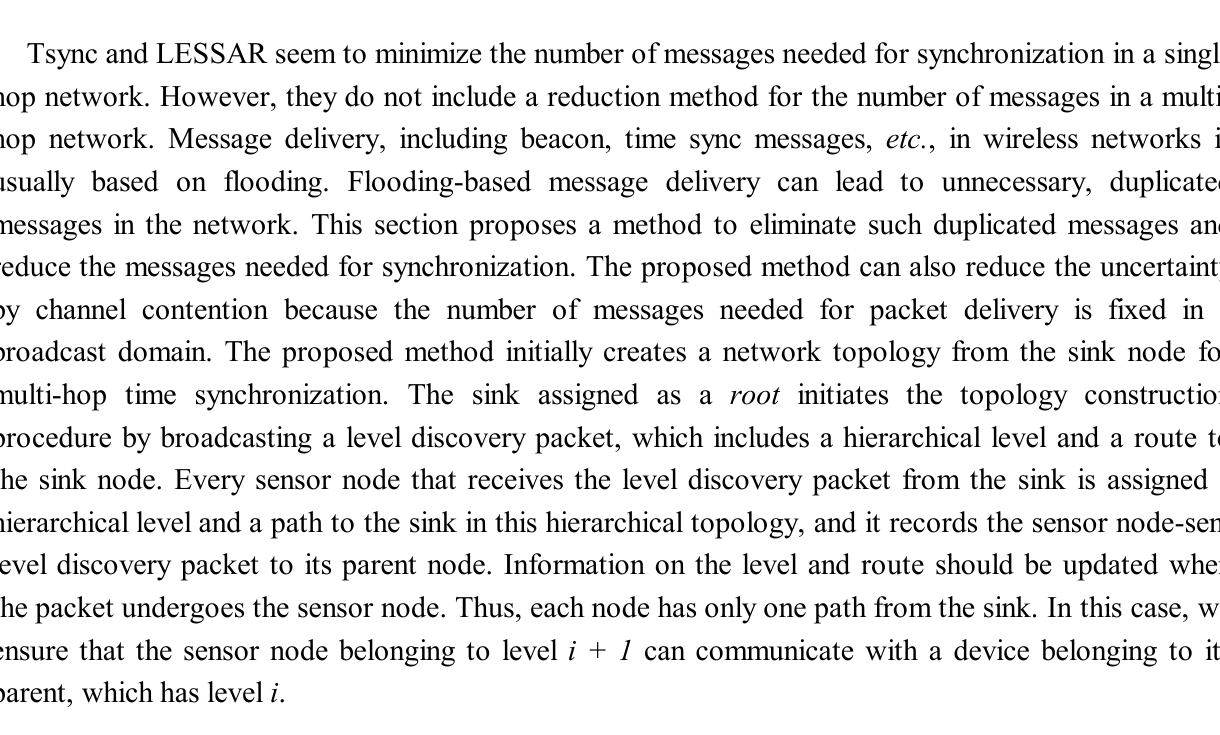
Figure 6. Topology construction procedure for multi-hop time synchronization. (a) Level